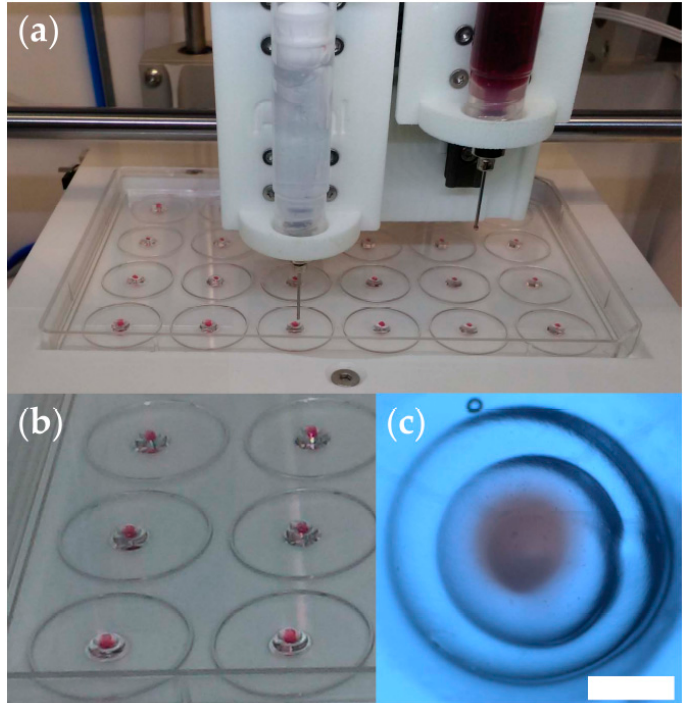
Figure 1. Optimization of the 3D bioprinting procedure. ( a ) Snapshot of a test print using the INKREDIBLE bioprinter to deliver hydrogel constructs onto the lid of a 24-well cell culture plate; here, we used ultrasound transmission gel to model the peritumoral medium, and the same gel stained with neutral red dye to model the tumor; ( b ) photograph of triple-layered structures obtained in test-prints. ( c ) Stereomicroscopy image (top view) of a representative triple-layered structure (scale bar = 1 mm).